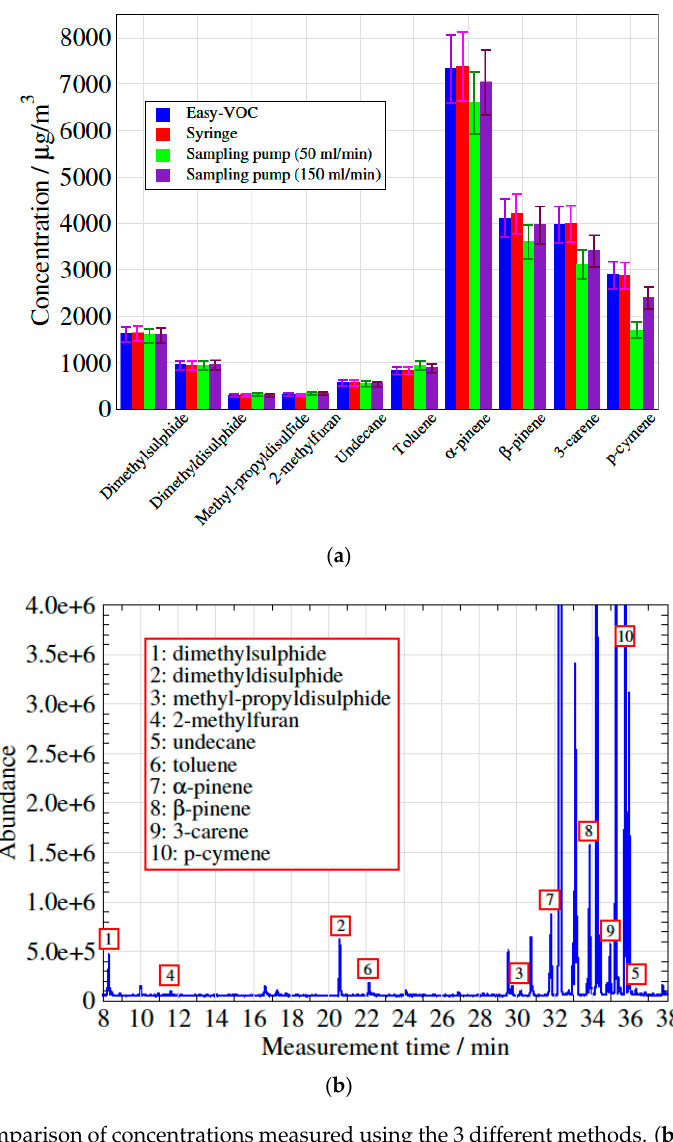
Figure 5. ( a ) Comparison of concentrations measured using the 3 different methods. ( b ) Chromatogram obtained with method 1.